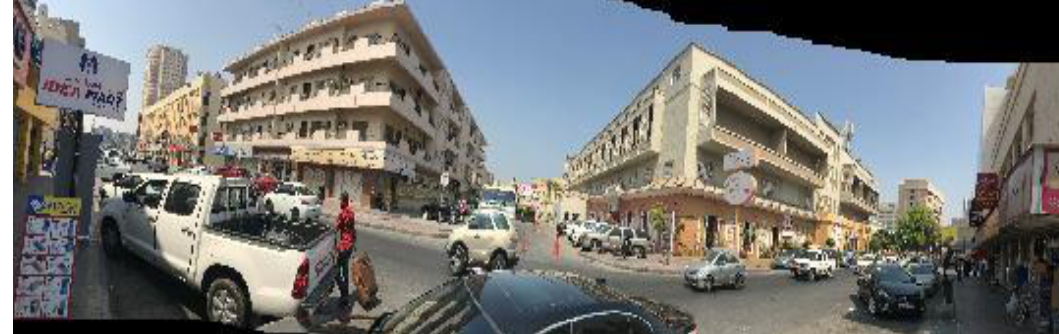
Figure 22: Falling of laws and regulations in control the visual